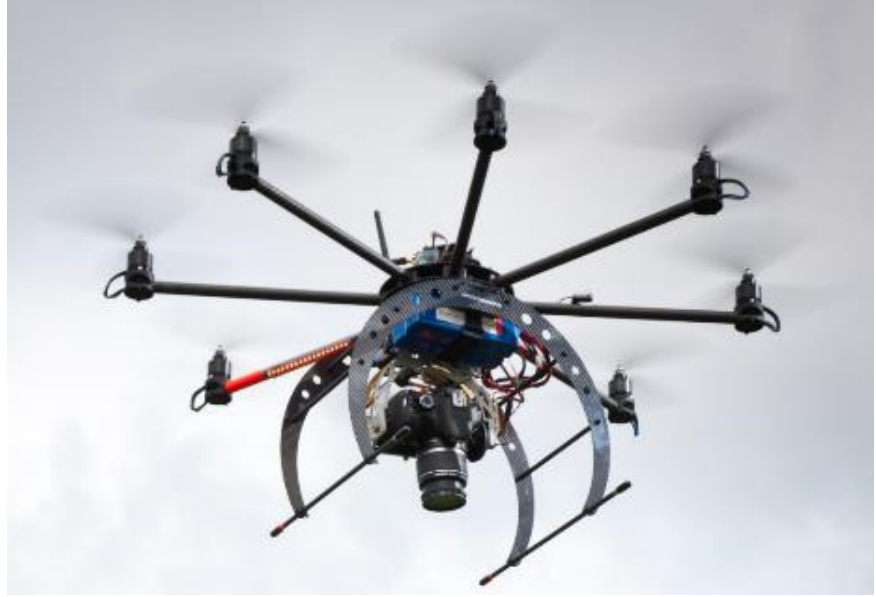
Figure 1. Oktokopter in flight, fitted with Canon 550D